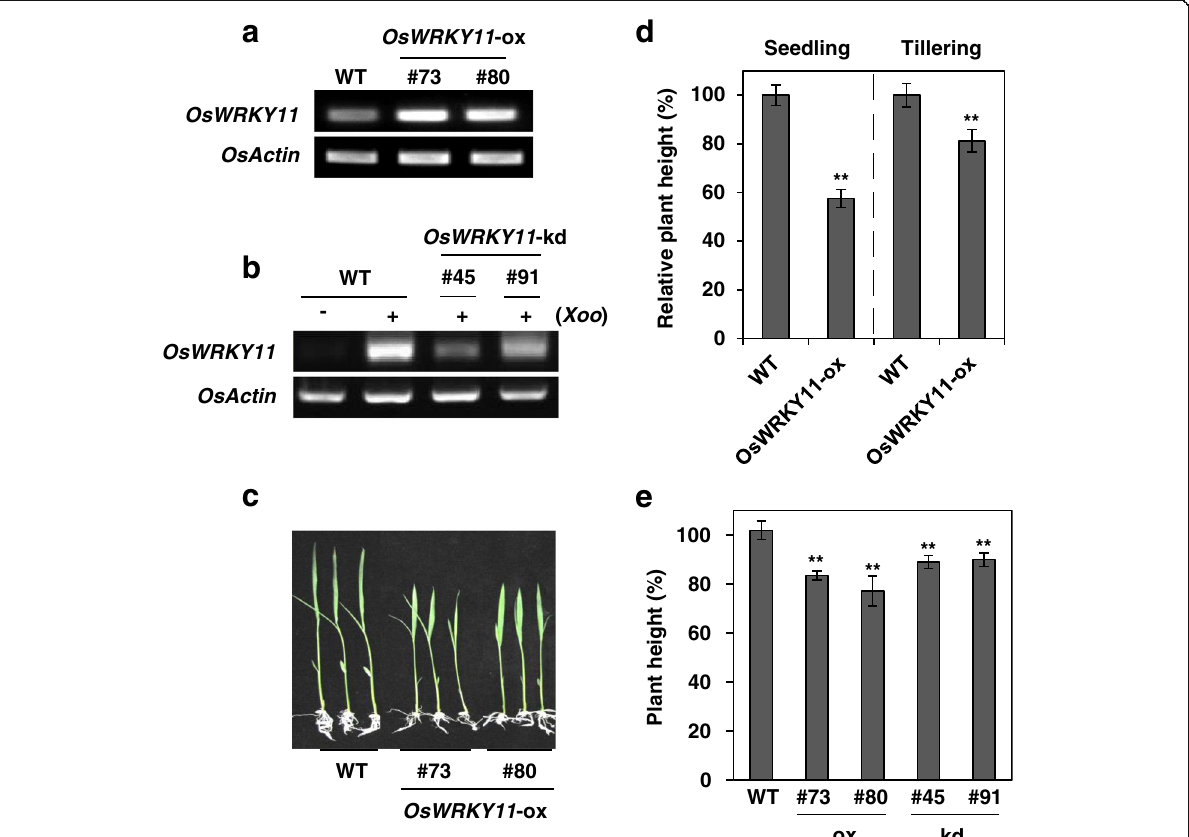
Fig. 1 Analysis of OsWRKY11 -ox and RNAi (kd) plants. OsWRKY11 -ox lines and OsWRKY11 -kd lines of Nipponbare cultivar were generated. Over-expression ( a ) and knock-down ( b ) of OsWRKY11 in these lines were confirmed by RT-PCR with gene-specific primers against OsWRKY11 (Table S1). Growth retardation of OsWKRY11 -ox transgenic rice at the seedling and tillering stages. The photograph shows 10-day-old seedlings grown in MS medium( c ). The relative heights of OsWKRY11 -ox transgenic plants were obtained by comparing 10-day-old transgenic and WT seedlings grown in MS medium, and 10-week-old transgenic and WT plants at the tillering stage grown in a greenhouse ( d ). Growth retardation of OsWKRY11 -ox and OsWRKY11 -kd transgenic rice grown